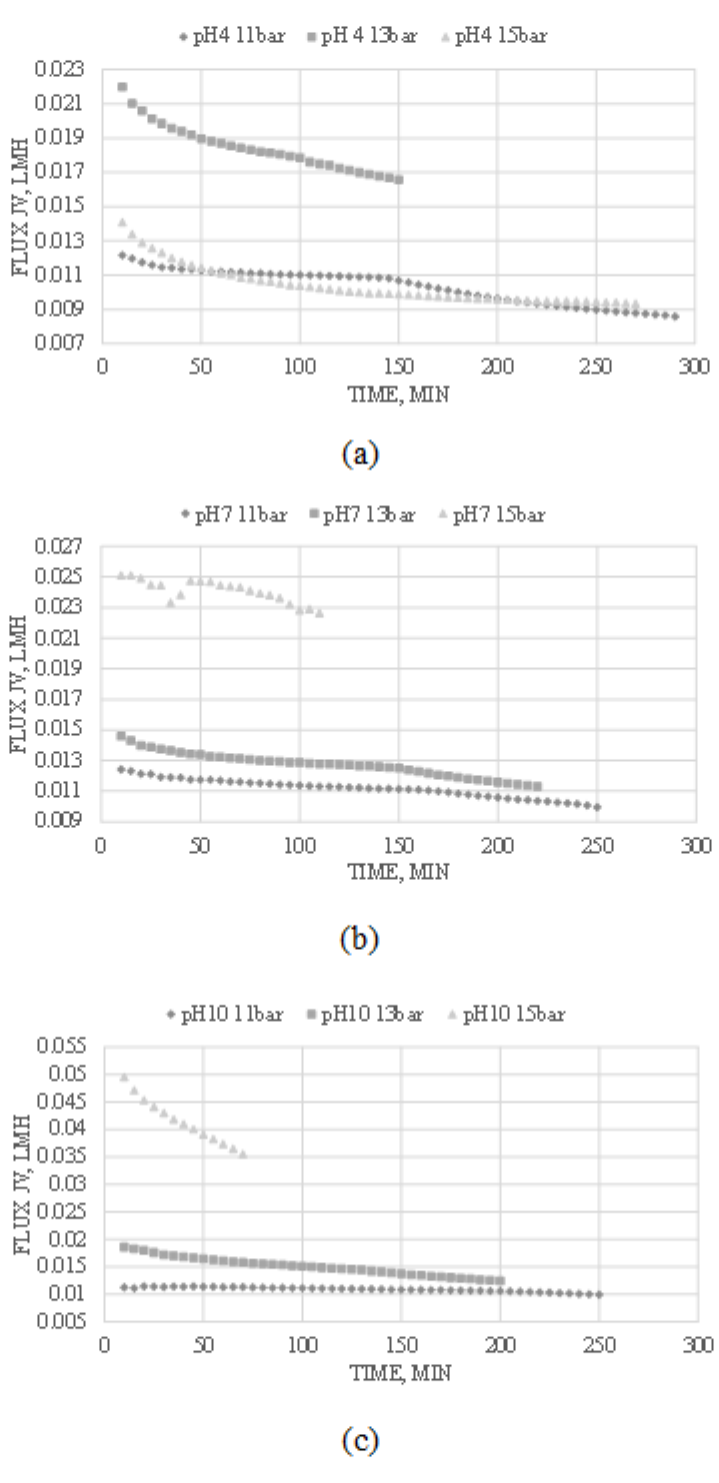
Figure 2. Effect of operating conditions on solution flux by nanofiltration separation at ( a ) pH 4; ( b ) pH 7; ( c ) pH